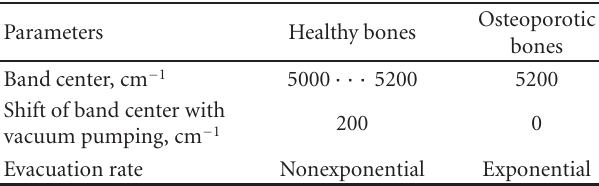
Table 2: Parameters of absorption bands of healthy and osteo- porotic